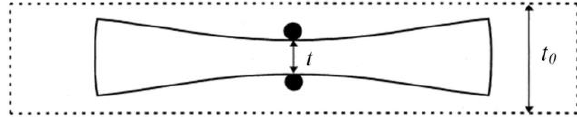
Figure 1. Special strain gauge for testing the specimen thickness variation.